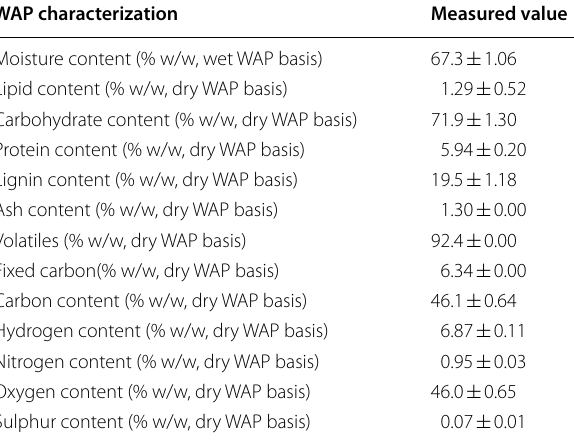
Table 2 Total polyphenolic compound (TPC) extraction from apple pomace (AP) with water-only at solid/solvent ratio 1:20